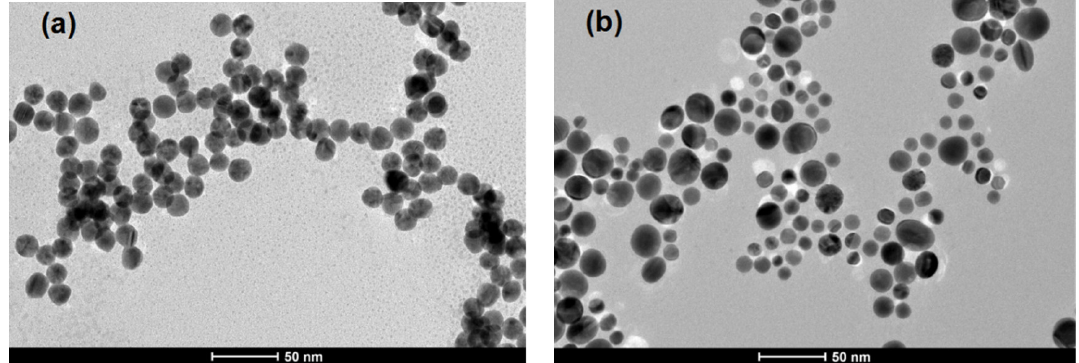
Figure 1. TEM micrographs of the differently charged gold nanoparticles (AuNPs): ( a ) negatively charged AuNPs; ( b ) positively charged AuNPs.